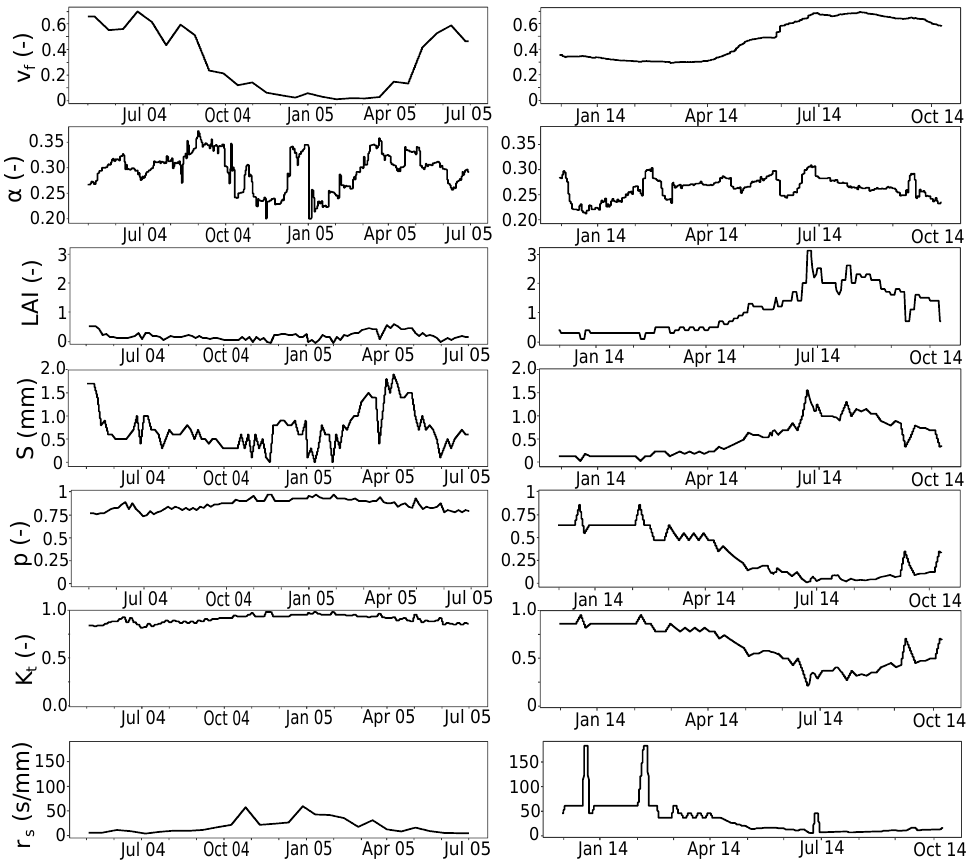
Figure 4. Remotely sensed derived time series of v f , α , leaf area index (LAI), S, p, k t , and r s for ARM-CF (left column) and MOISST (right column) during their corresponding model calibration